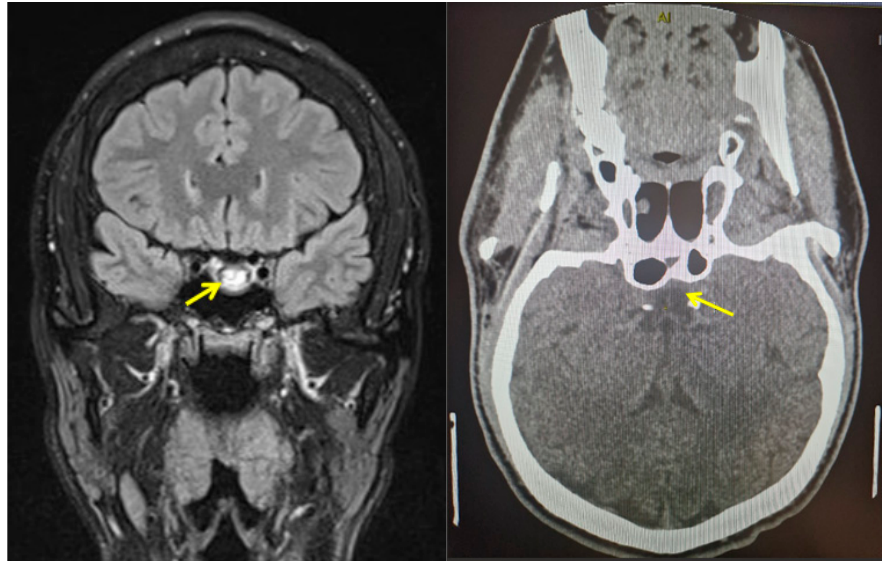
Figure 3. Imaging capture of a pituitary apoplexy. This is a male patient in his late 20s diagnosed with pituitary apoplexy with no prior medical or surgical history. On first presentation as an outpatient (due to severe headache), magnetic resonance imaging (performed as an emergency) shows a pituitary mass of 2.5 cm maximum diameter with inhomogeneous pattern suggesting hemorrhage (yellow arrow) at the level of a pituitary tumor ( left ). Intravenous contrast computed tomography (10 months since transsphenoidal surgery) shows a tendency to empty sella and no tumor remnants (yellow arrow) at the same level ( right ). Both captures are coronal plane.